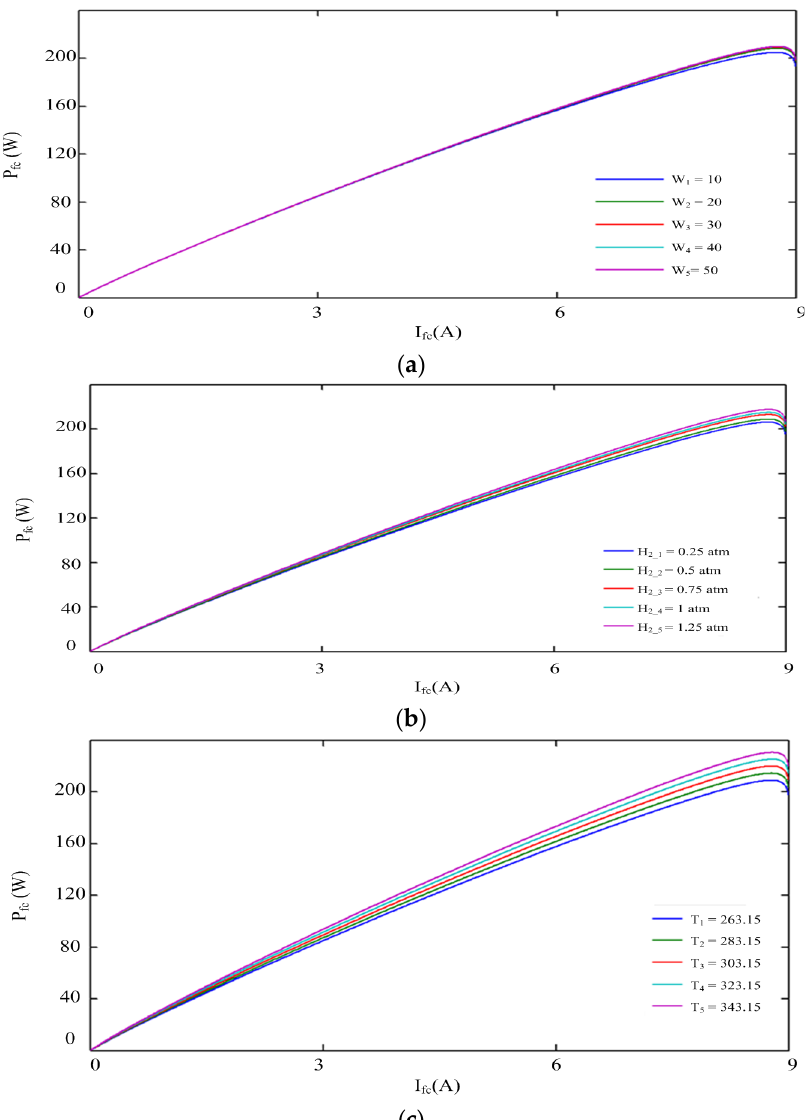
Figure 4. Characteristic curves of the tested fuel cell. ( a ) Characteristic curves of power ‐ current under different humidity; ( b ) Characteristic curves of power ‐ current under different hydrogen pressures; ( c ) Characteristic curves of power ‐ current under different temperatures.